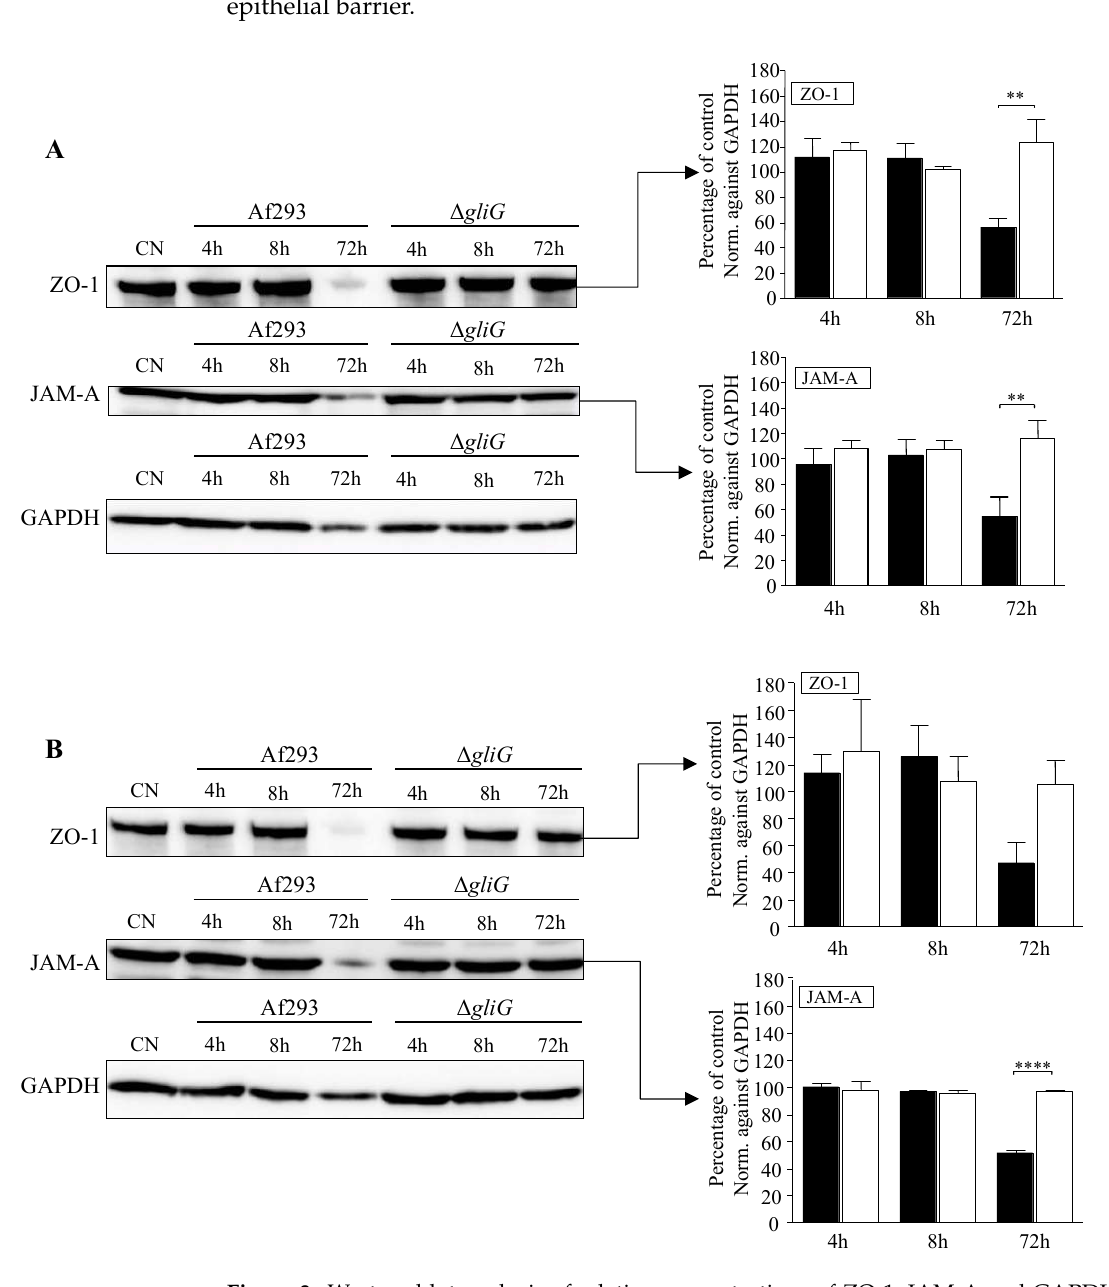
Figure 3. Western blot analysis of relative concentrations of ZO-1, JAM-A and GAPDH in CFBE and HBE monolayers following exposure to supernatants of A. fumigatus and ∆ gliG . Western blots of ZO-1, JAM-A and GAPDH proteins from CFBE ( A ) and HBE ( B ) monolayers following 24 h exposure to culture medium alone (CN) or 4 h, 8 h or 72 h supernatants of Af293 or ∆ gliG . Bar charts present densitometric analysis of ZO-1 (225 kDa) and JAM-A (36 kDa) bands from western blots to determine relative protein levels of monolayers exposed to Af293 supernatants (black bars) and ∆ gliG supernatants (white bars). Band intensities from three independent experiments were normalised against GAPDH values and are expressed as the mean percentage of the control. Error bars represent standard error of at least three independent replicates. ** p < 0.01, **** p < 0.0001.